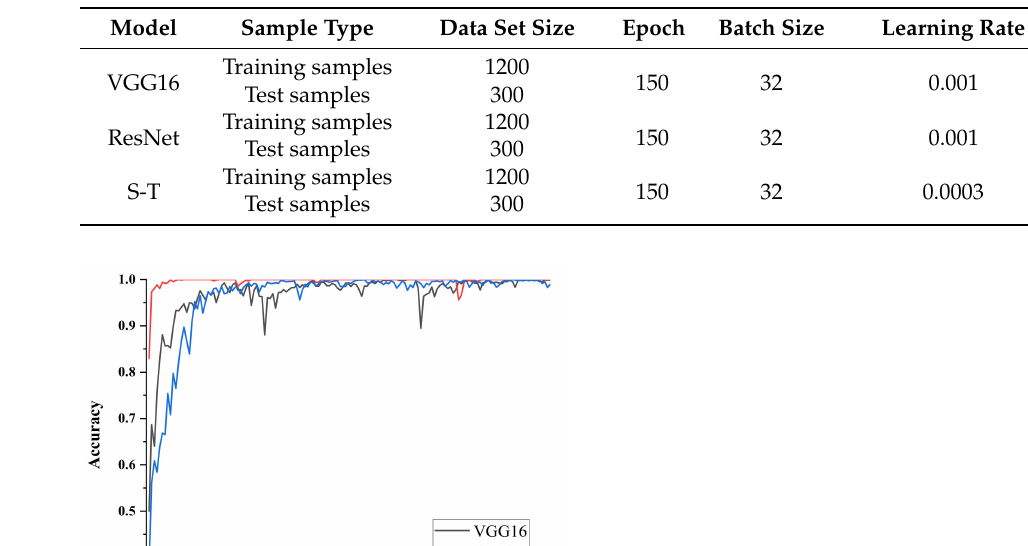
Table 5. Training parameters of model.